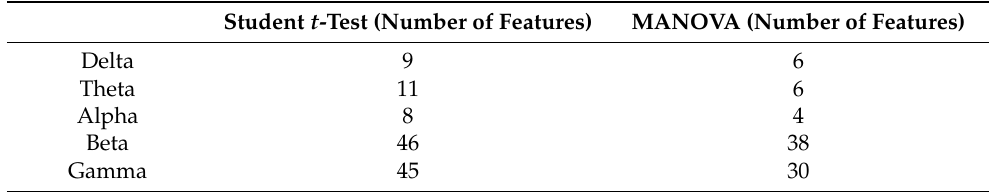
Table 1. Number of features retained after feature extraction